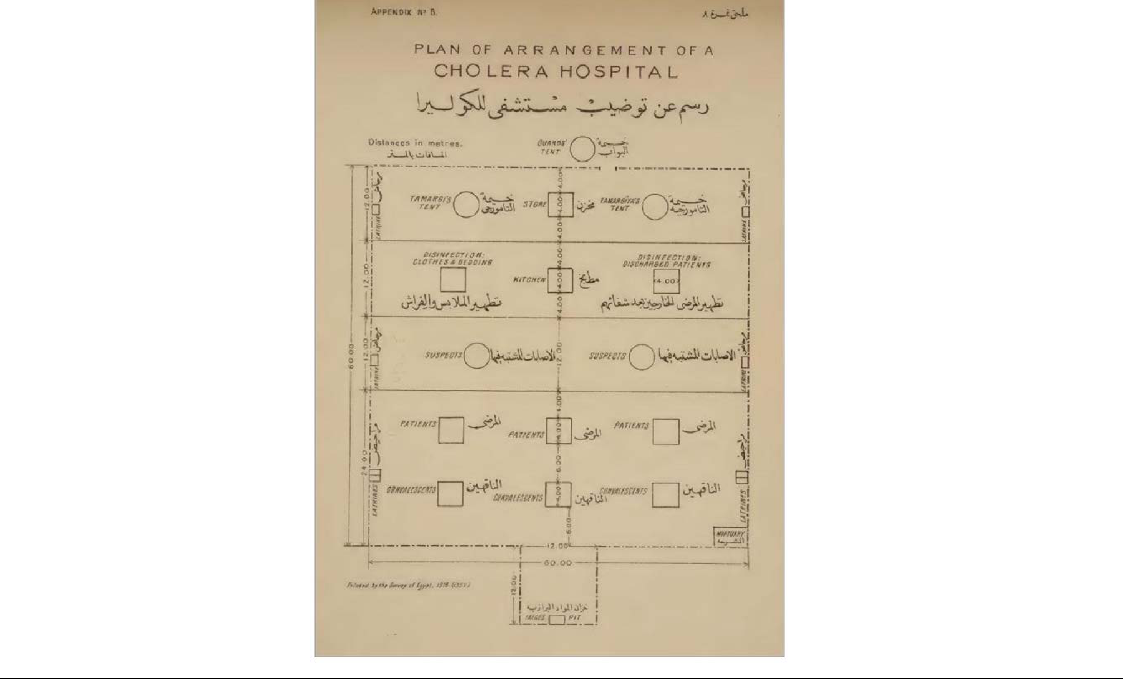
Figure 5. Plan of Arrangement of a Cholera Hospital (Source: Department of Public Health, Instructions on Procedure in Outbreaks of Cholera [Cairo: Government Press, 1918]; Wellcome Collection,